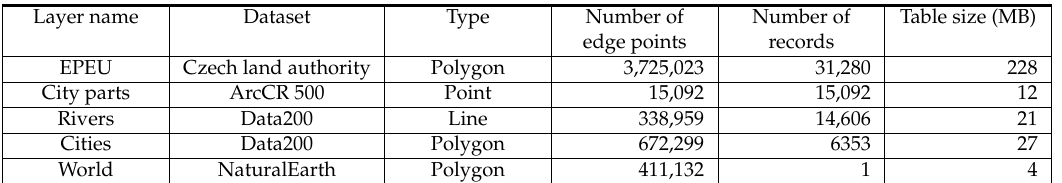
Table 2. Information about data